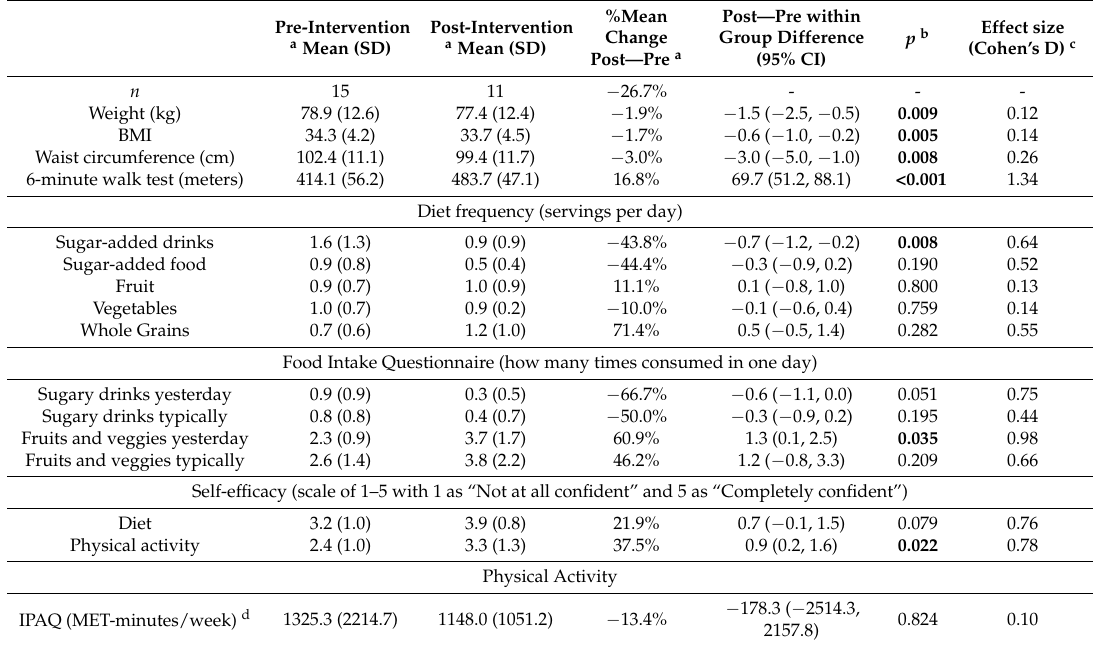
Table 3. Changes in anthropometric variables, physical fitness, diet, and self-efficacy. %Mean Post—Pre within Pre-Intervention Post-Intervention Change Group Difference p a Mean (SD) a Mean (SD) Post—Pre a